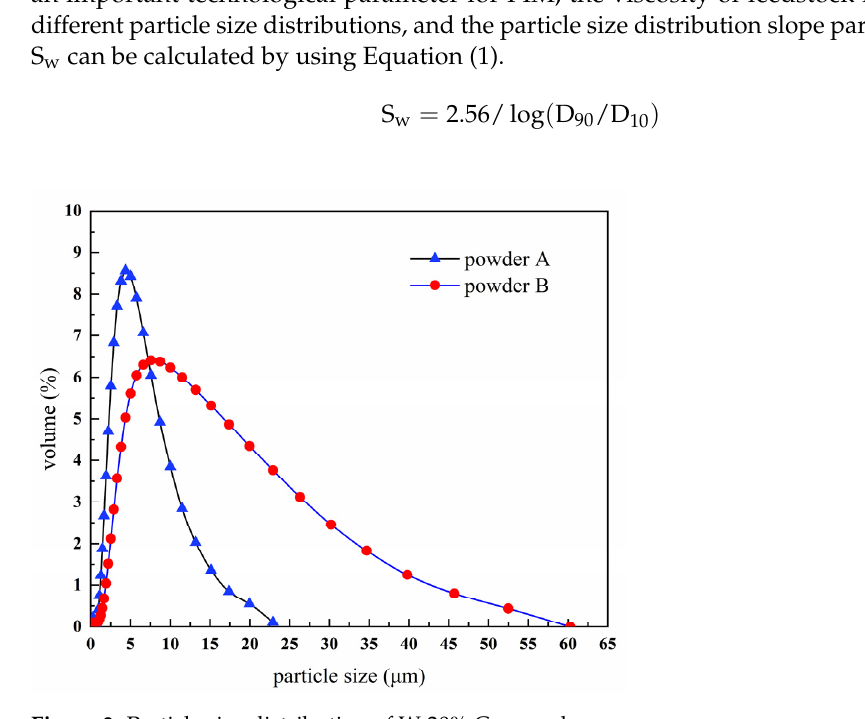
Figure 3. Particle size distribution of W-20% Cu powders. Table 2. Powder characteristics of W–20% Cu